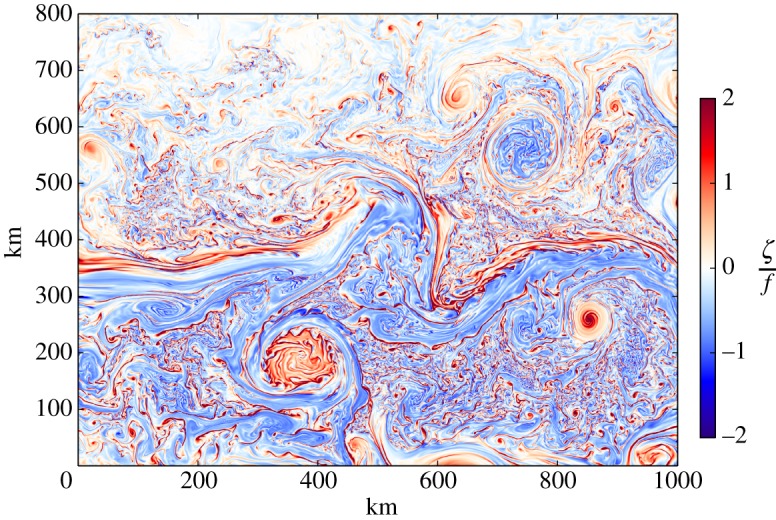
Vertical vorticity ζ normalized by f at the surface in the wintertime Gulf Stream after separation from the western boundary in a nested-subdomain simulation. Notice the meandering Stream in the centre, the northern warm anticyclonic and southern cold cyclonic mesoscale Rings, and the nearly ubiquitous submesoscale features of many types: North Wall ‘comma’ instabilities and streamers, Ring interior instabilities, cyclonic coherent vortices, and ‘submesoscale soup’ in-between. Notice the asymmetry between the red and blue colours: cyclonic vorticity is typically stronger in the surface layer, due to finite-Ro effects of vortex stretching in (5.4) and ageostrophic instabilities (§6a) and loss of balance (§6d) that limit the anticyclonic vorticity amplitude to ζ/f≳−1. The colour bar does not fully span the field range; i.e. there are many places with ζ/f>2 [27].